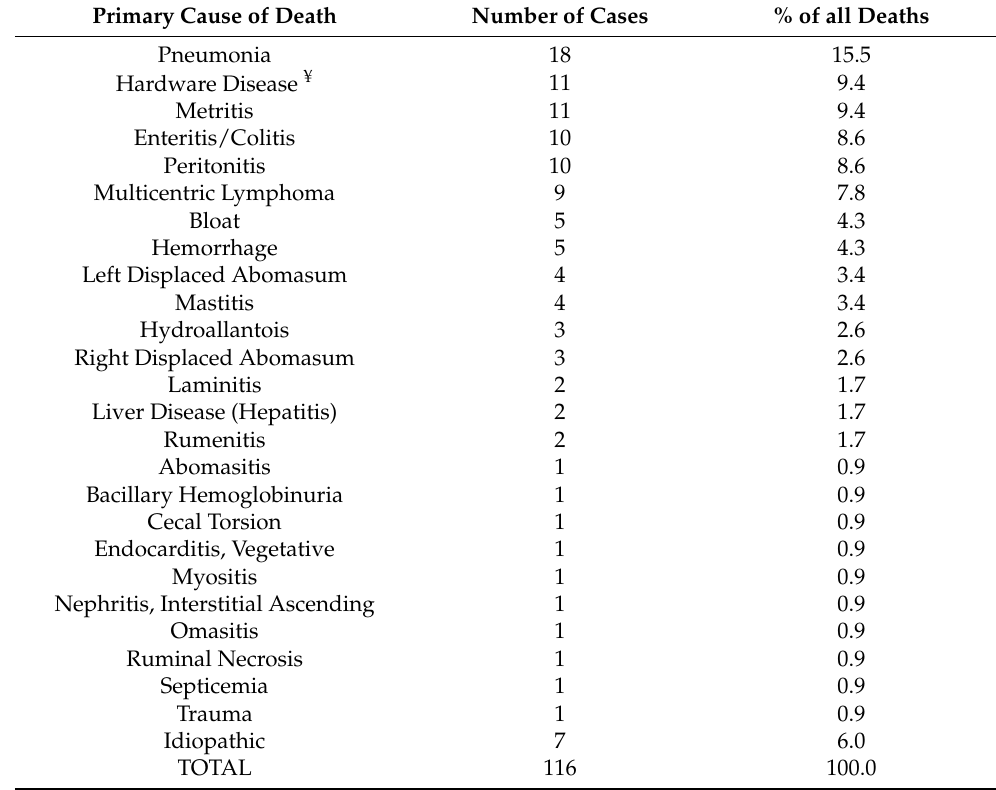
Table 8. Primary cause of death of 116 cattle > 4 years old (oldest 9 years old) diagnosed at